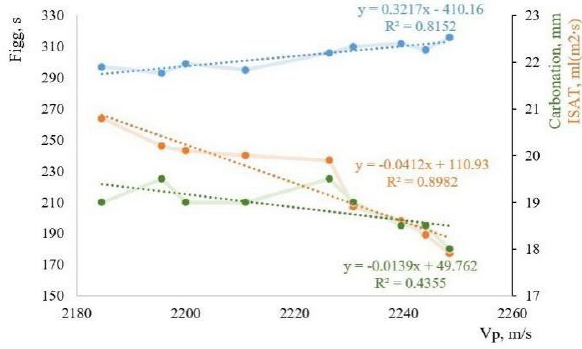
Figure 4: Plots of the dependence of the Figg index and carbonation degree on wave propagation velocity for concrete after pipe burst simulation. ( Source: authors’ elaboration )